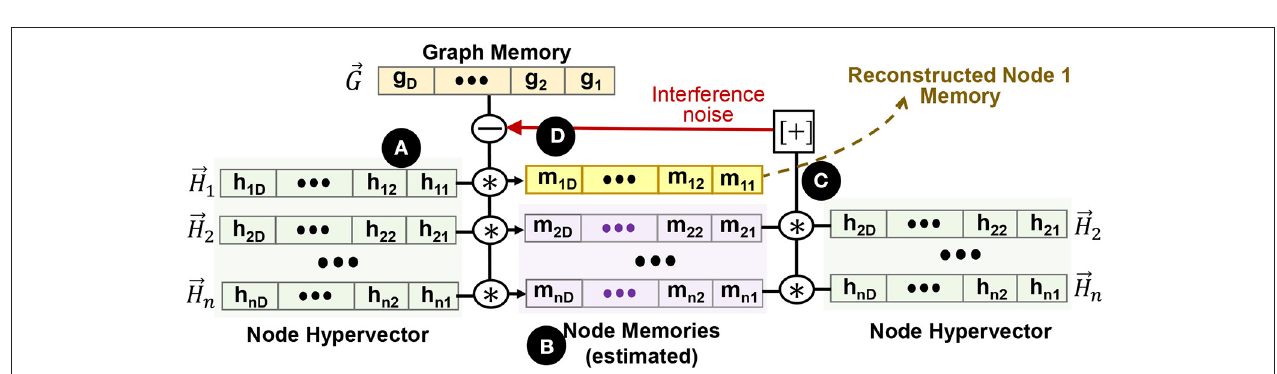
FIGURE 5 | Node memory reconstruction. (A) node hypervectors, (B) estimated node memory based on node hypervectors, (C) cross-interference noise estimation, and (D) recursive noise cancellation in graph memory.